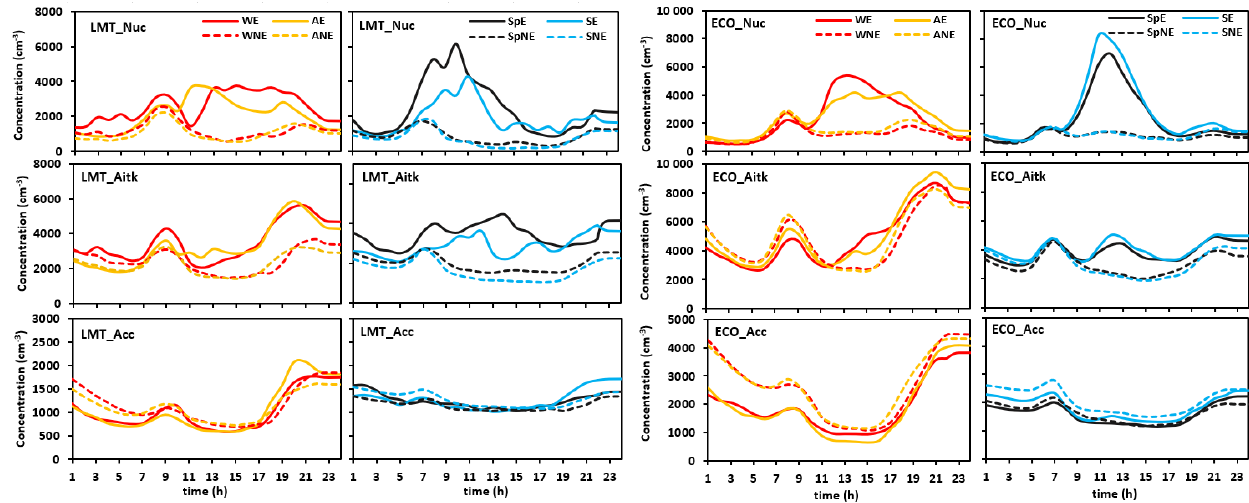
Figure 4. Average diurnal variation in nucleation, Aitken, and accumulation mode particle number concentrations (from top to bottom) over the whole period of study at LMT and ECO. Solid lines are for NPF events days (E), and dashed lines are for non-events days of (NE); red is for winter, gray is for spring, blue is for summer, and yellow is for